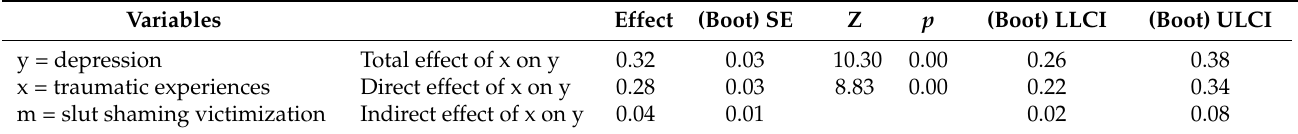
Table 5. Mediation analyses—Predictors of